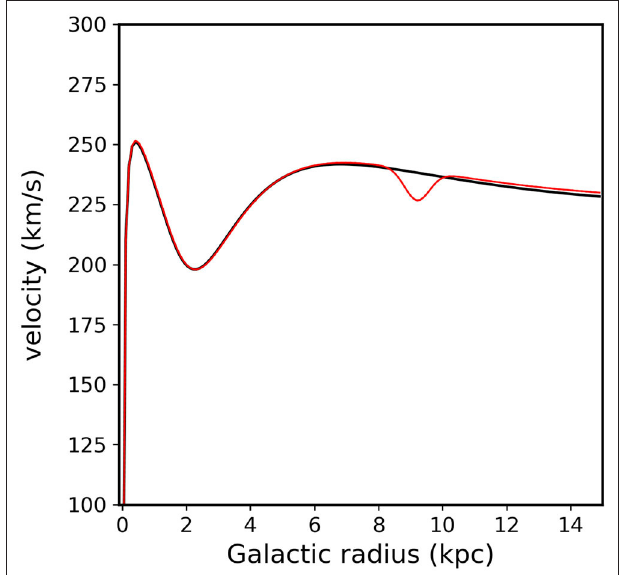
FIGURE 6 | Rotation curves of the Galaxy that can be classified as plane and plane with a dip centered at 9.2kpc. The analytical expressions for both rotation curves are given by Equations (2) and (3),